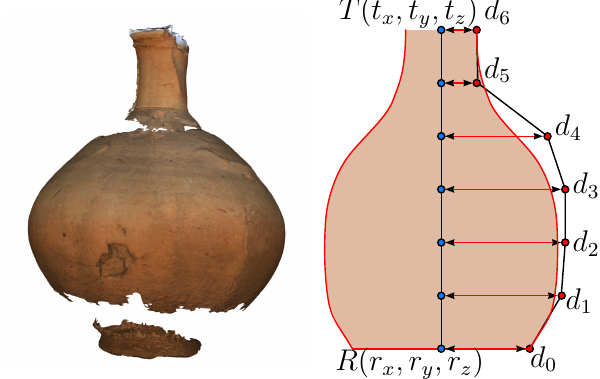
Figure 4. The vase on the left-hand side is a digitized artifact of the “Museum Eggenberg” collection. It consists of 364,774 vertices and 727,898 triangles. The example of a procedural shape on the right-hand side takes two points R and T in 3D and distance values, which define the control vertices of a Bézier